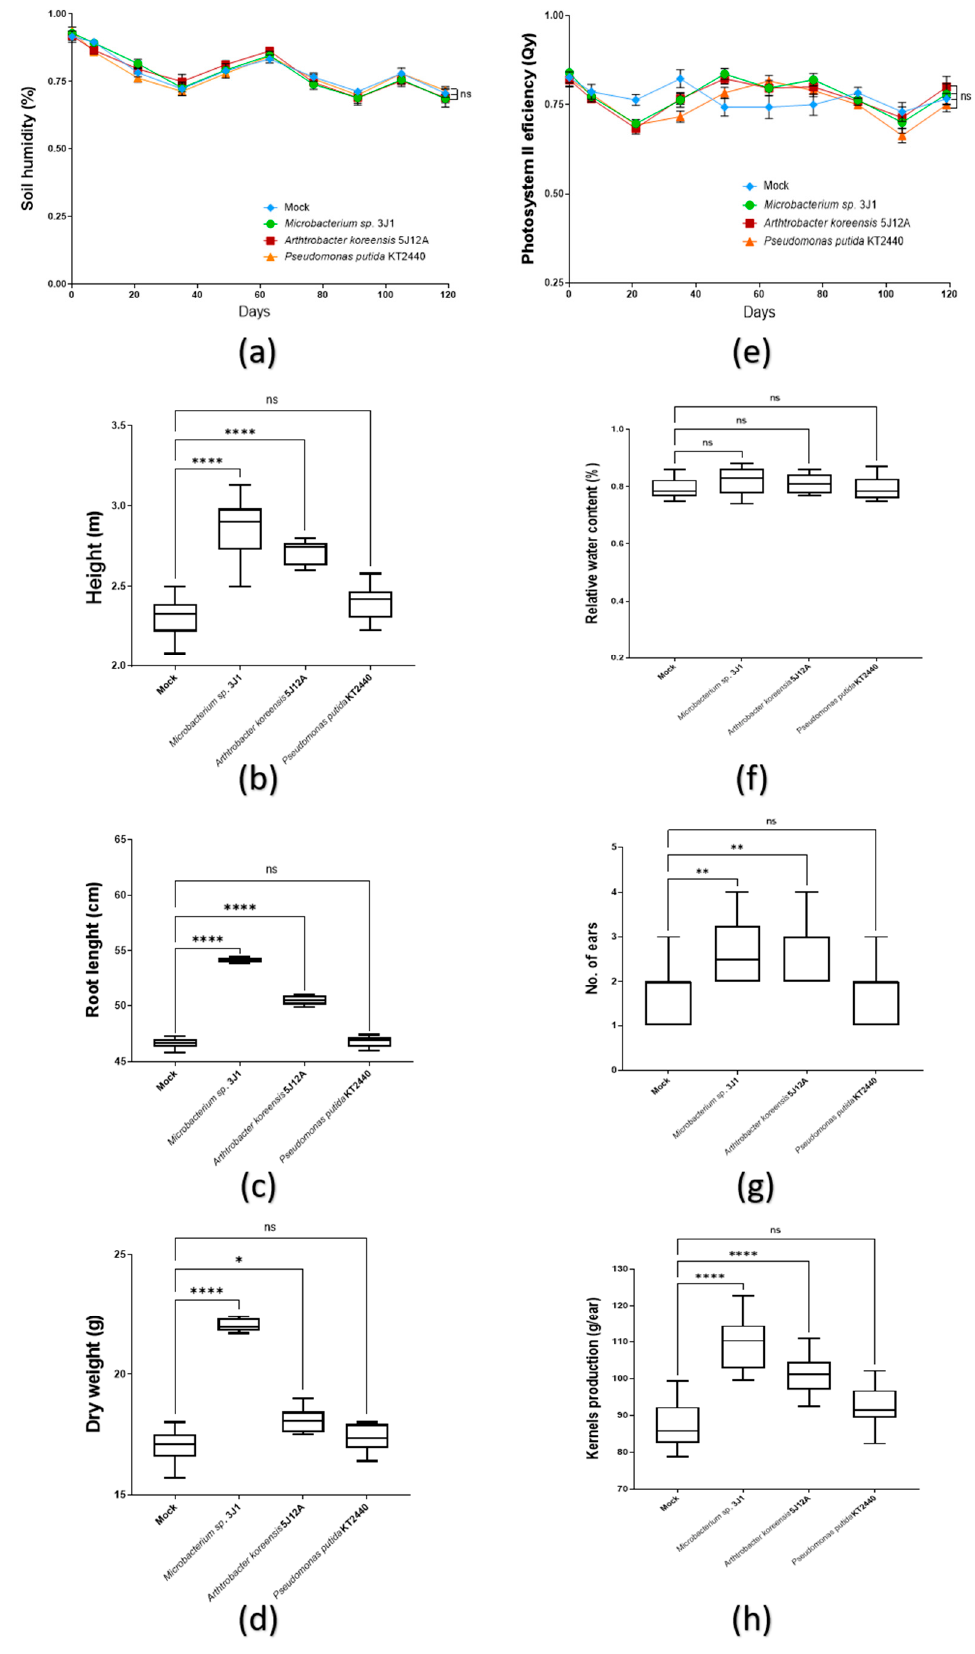
Figure 5. Evaluation of capsule treatment 120 DAT in maize plants under regular irrigation. ( a ) The line graph shows soil humidity representative data from three independent experiments ( n = 9); ( b )